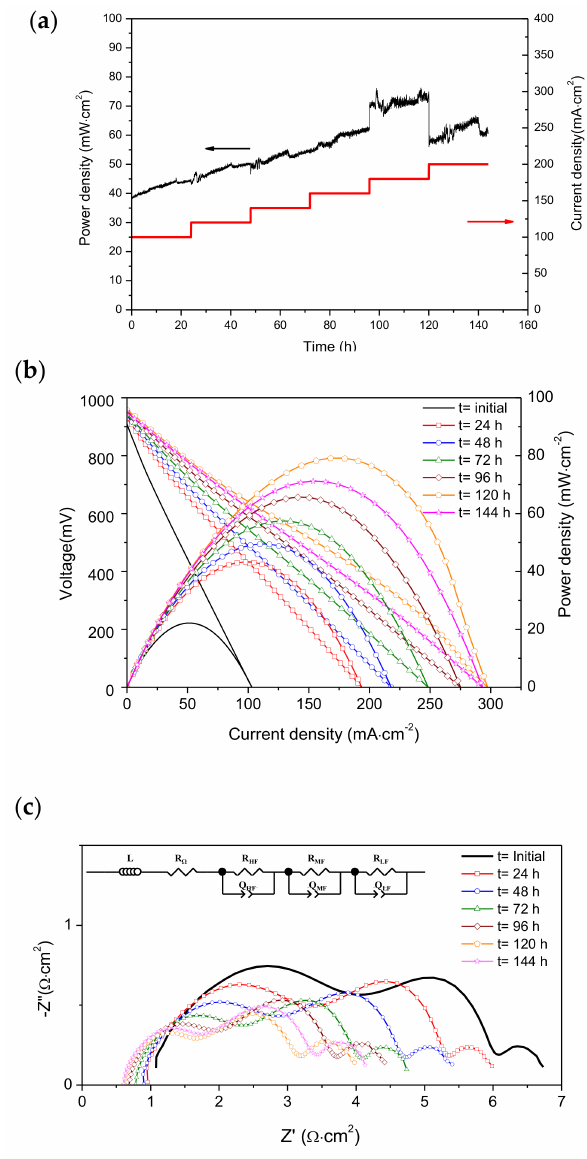
Figure 2. ( a ) Results of electrochemical tests on the cell (Ni-CYSZ / YSZ / LSM) in wet CH 4 (3% H 2 O) at 850 ◦ C. Power density and current density versus time, ( b ) I-V curves, and ( c ) impedance spectra (the inset shows the equivalent circuit model used for impedance spectra